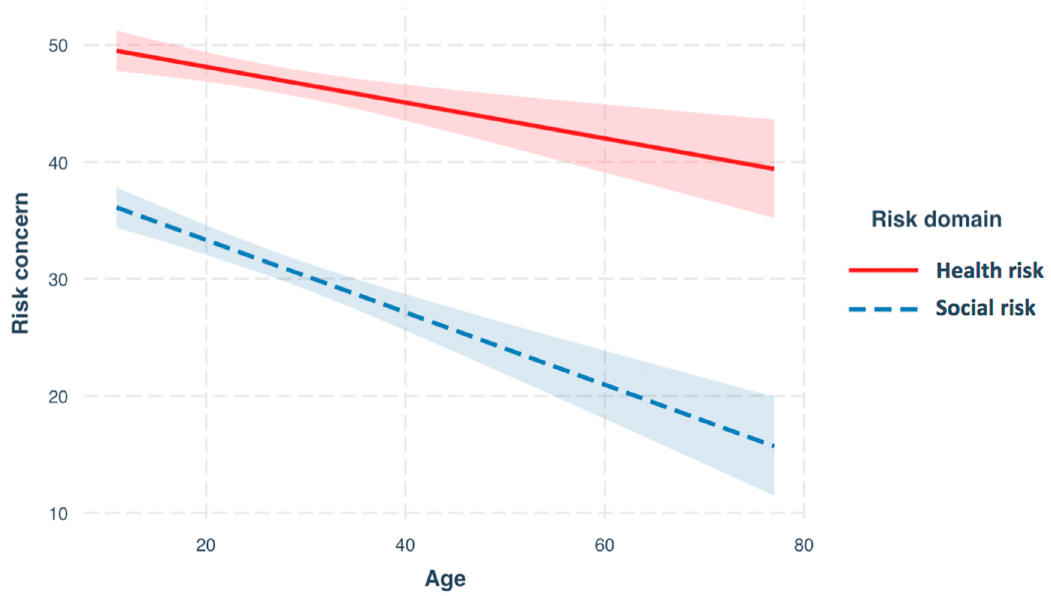
Figure 2. Relationship between age and concern for health risk (slope: β = − 0.15, p < 0.001) and social